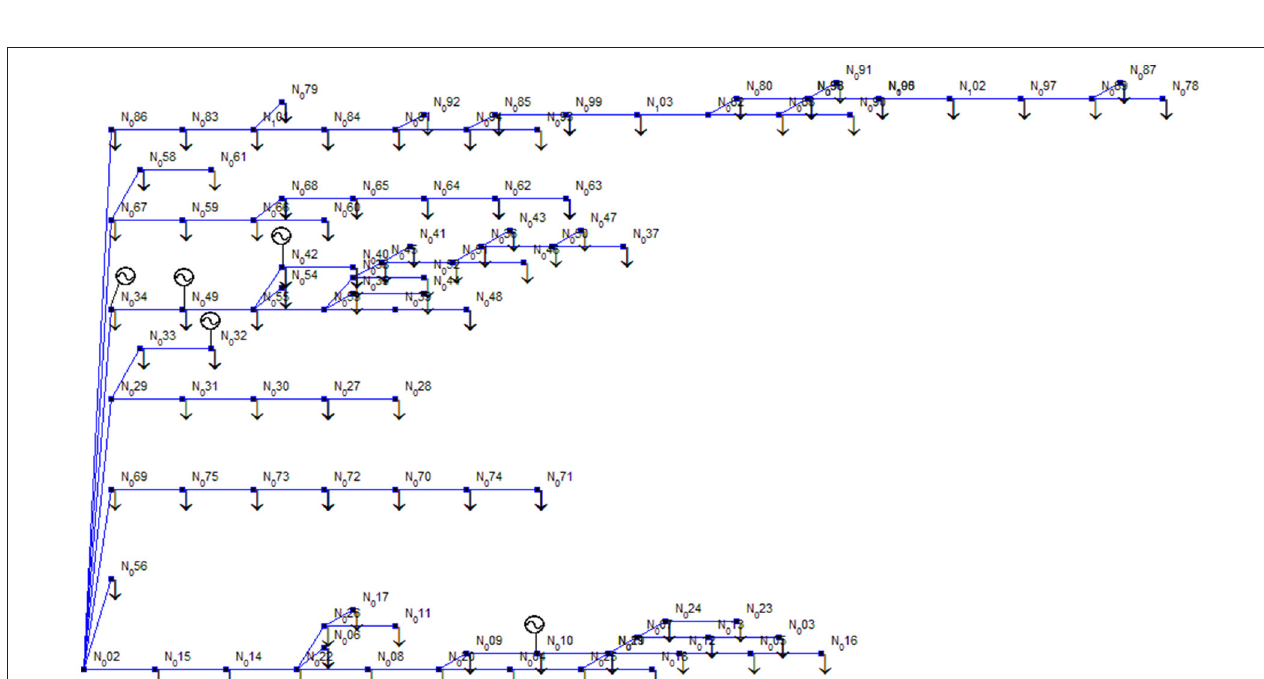
FIGURE 8 | Distribution network from Pilo et al. (2012, 2013,